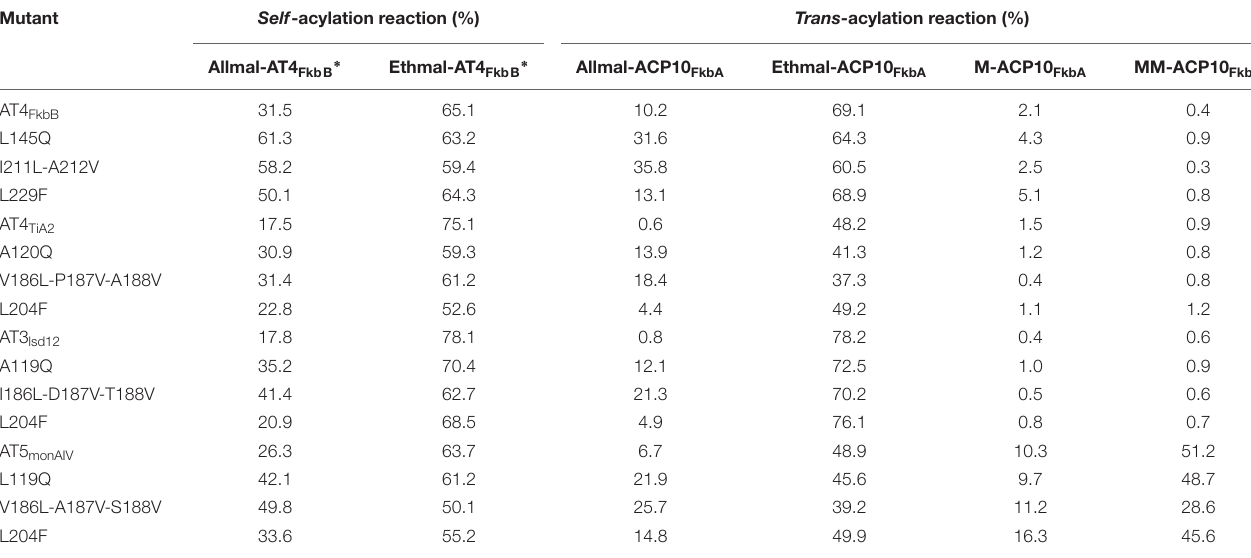
TABLE 2 | The activities of AT4 FkbB of FK520 PKS, AT4 TiA2 of fidaxomicin PKS, AT3 lsd12 of lasalocid PKS and AT5 monAIV of monensin PKS and their mutants with allmal- or ethmal-CoA as the substrate in self -acylation reactions and with allmal- or ethmal-, M-, MM-CoA as the substrate in trans -acylation reactions. Mutant Self -acylation reaction